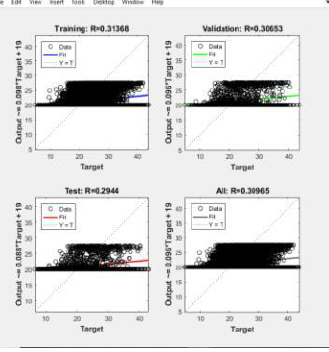
Figure 19 . The three plots represent the training, validation, and testing data. The dashed line in each plot represents the perfect result – outputs = targets. The solid line represents the best fit linear regression line between outputs and targets.